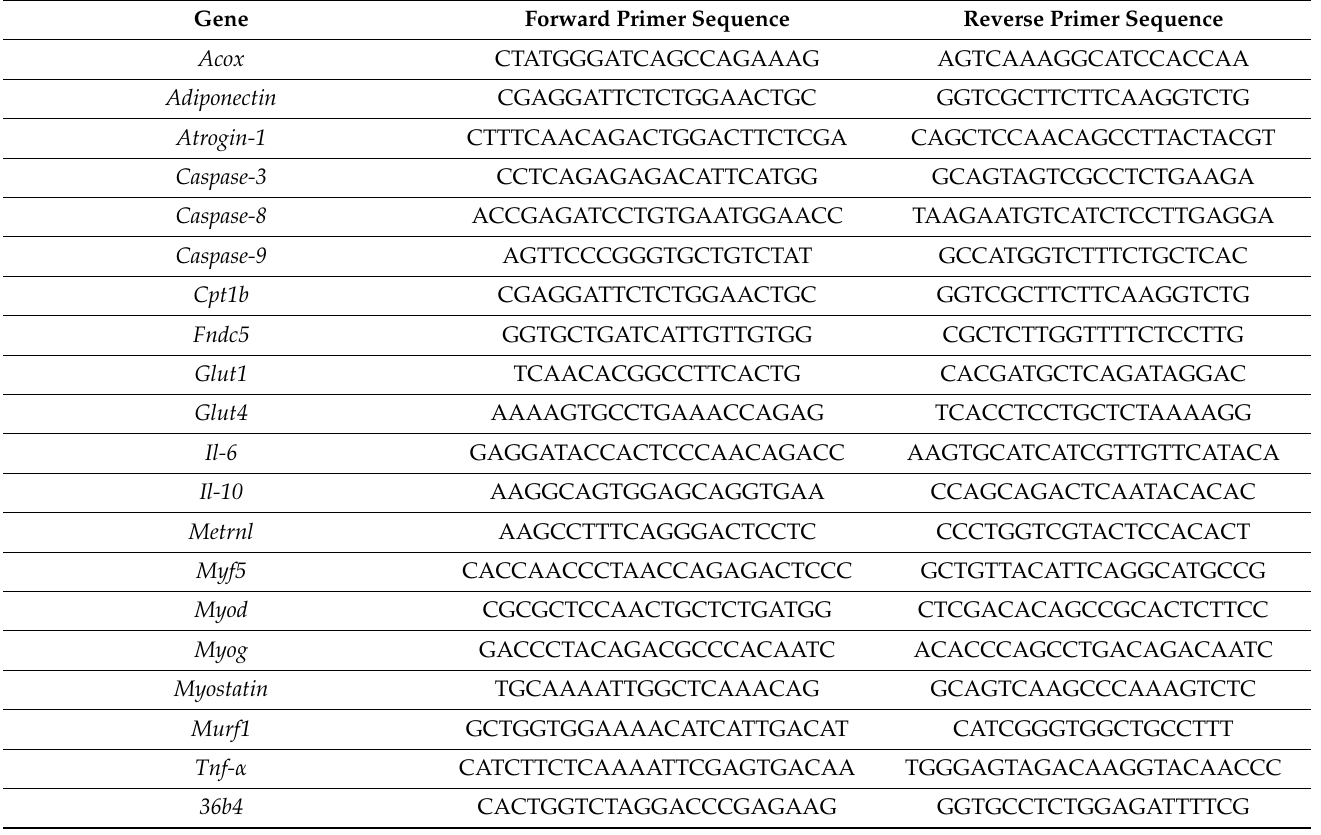
Table 1. Mouse primers sequences for SYBR GREEN